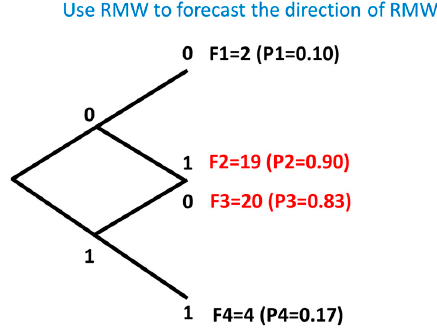
Figure A9. Use SMB to forecast the direction of SMB.